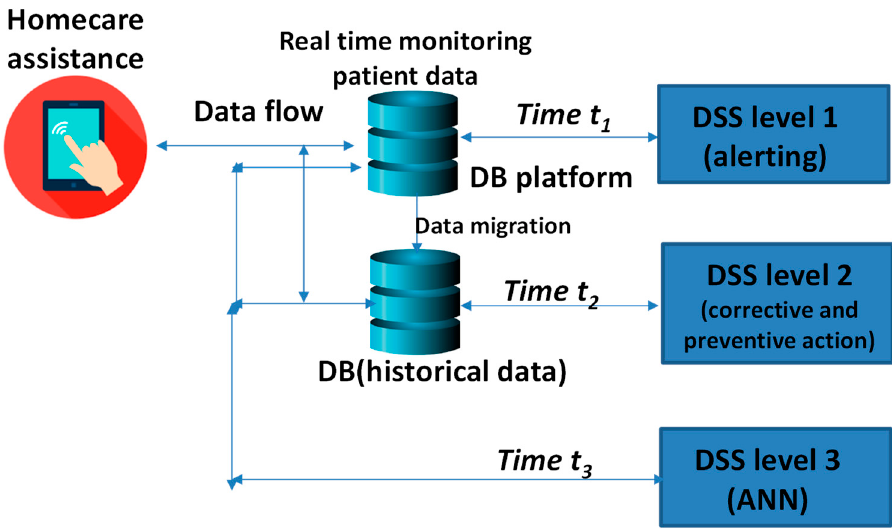
Figure 8. Control room: architecture of the multilevel DSS system ( t 1 < t 2 ≤ t 3 ).